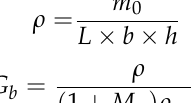
Table 1. The simply supported beam bending formula.